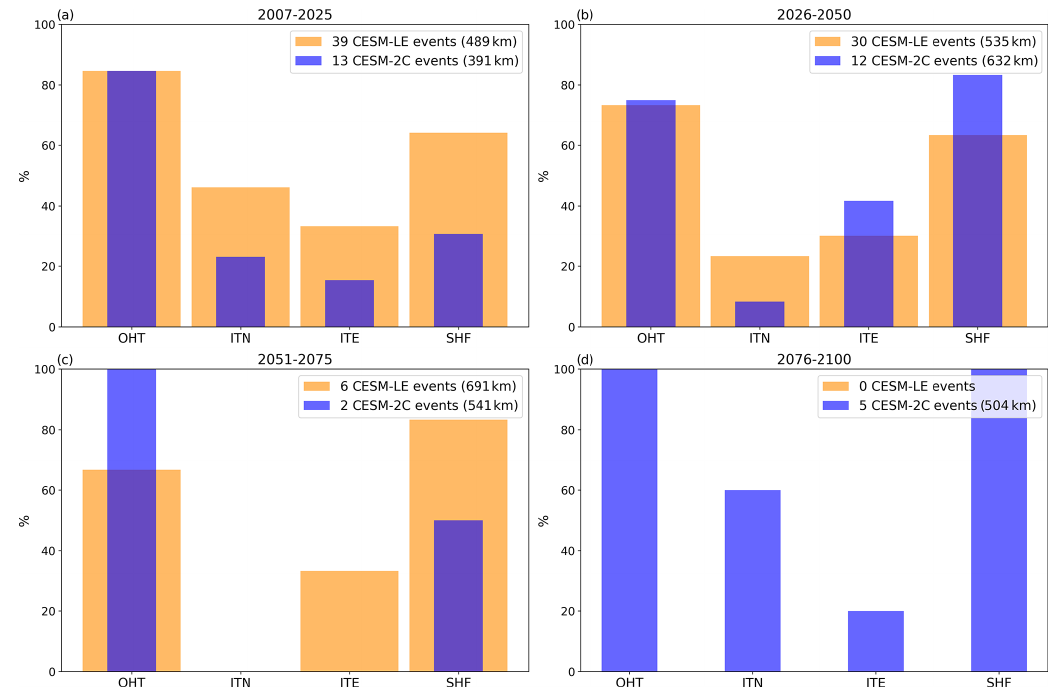
Figure 4. The fraction of RICEs that show a simultaneous trend in the respective forcing parameter of more than 1 standard deviation. The drivers are BSO ocean heat transport (OHT), ice transport through the northern (ITN) and eastern (ITE) gateway, and surface heat flux (SHF) in the southwestern Barents Sea (Fig. 5c). Note that as RICEs can be related to anomalous trends in more than one driver, ratios can add up to more than 100%. The average movement of the sea ice edge during RICEs is provided in the legend.